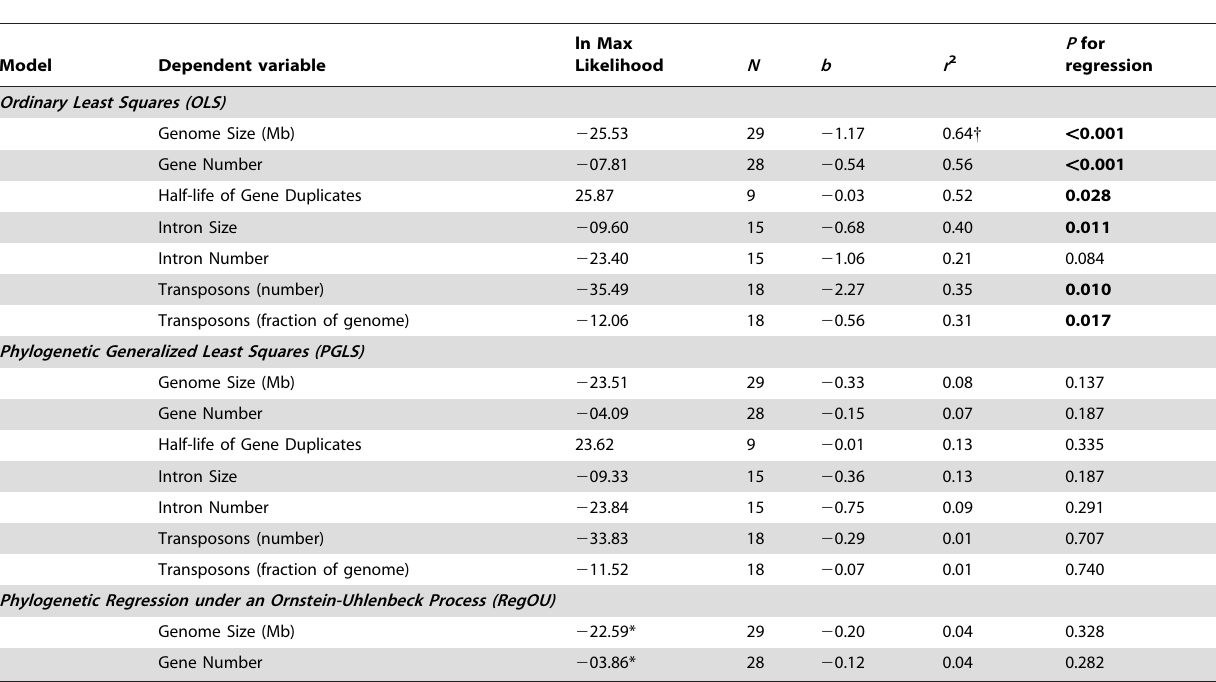
Table 1. Relationships between N e u and genomic attributes in nonphylogenetic (OLS) and phylogenetic (PGLS, RegOU) models.